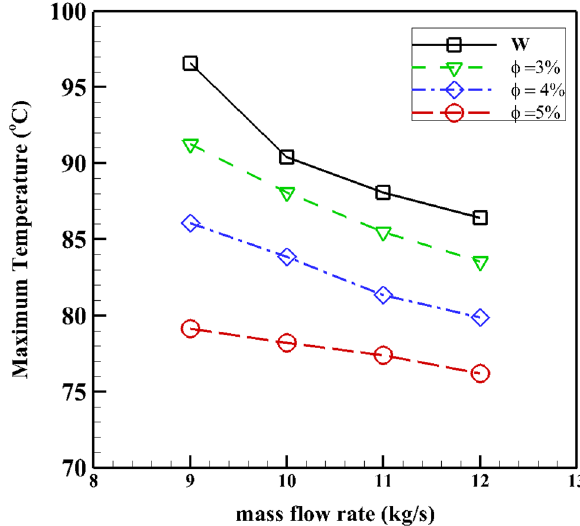
Fig. 18 Outlet temperature of WCP at constant flow rate vs concen-